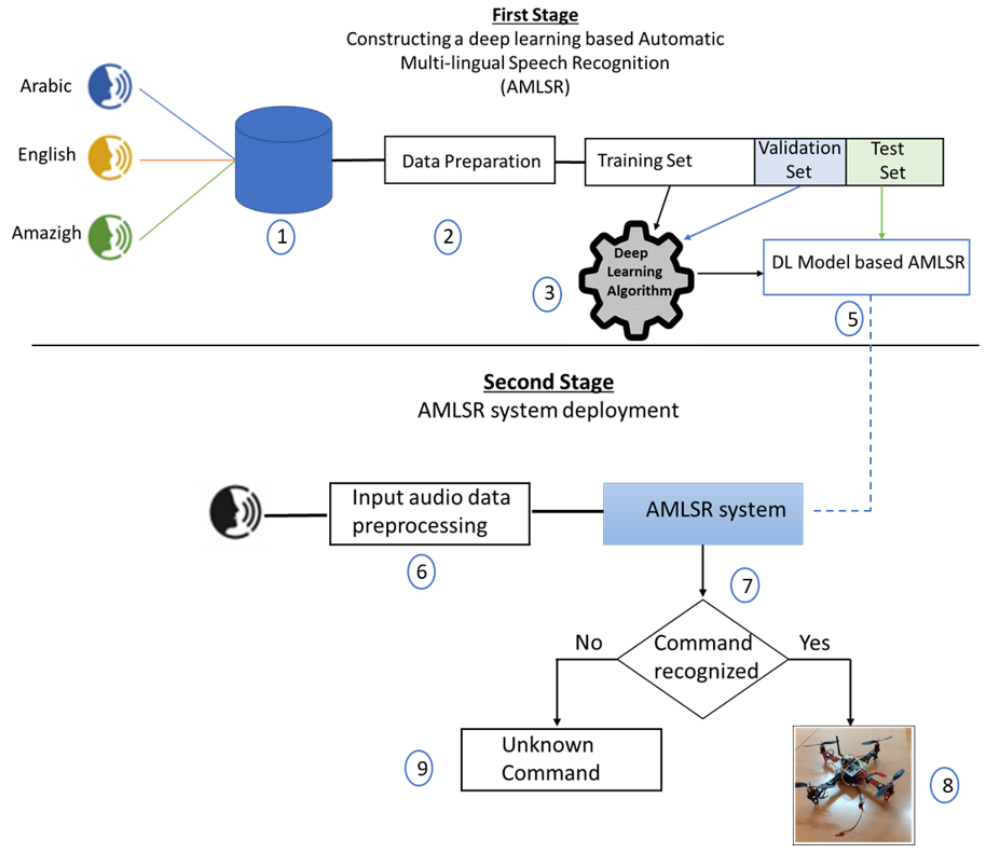
Figure 1. Block diagram of the proposed two-stage